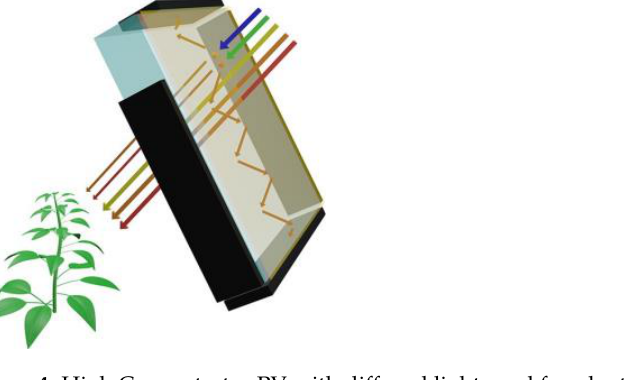
Figure 3. Different options for PV array tracking. ( A ) source: [26], ( B ) source: [37].